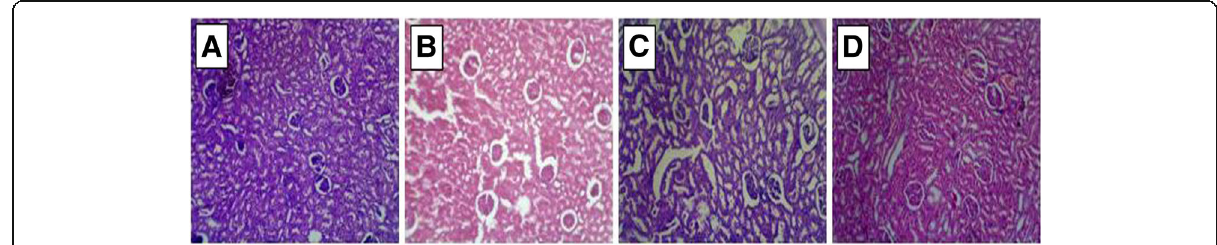
Fig. 11 Histopathological analysis of kidney tissue in various concentration. a : Control group, b : Low dose (300 mg/kg), c : Mild dose (600 mg/kg), d : High dose (1200 mg/kg)